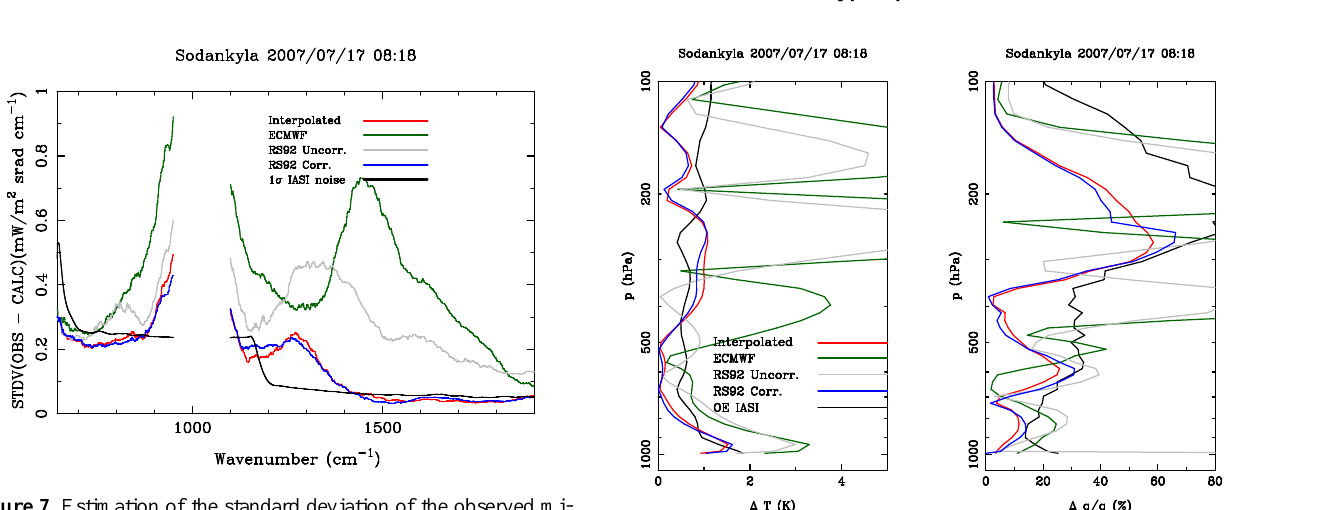
Figure 7. Estimation of the standard deviation of the observed mi- nus calculated radiance differences for each reference atmospheric profile, having removed the ozone band. Figure 8. Retrieval error (diagonal of Eq. (4) in black) and colloca-